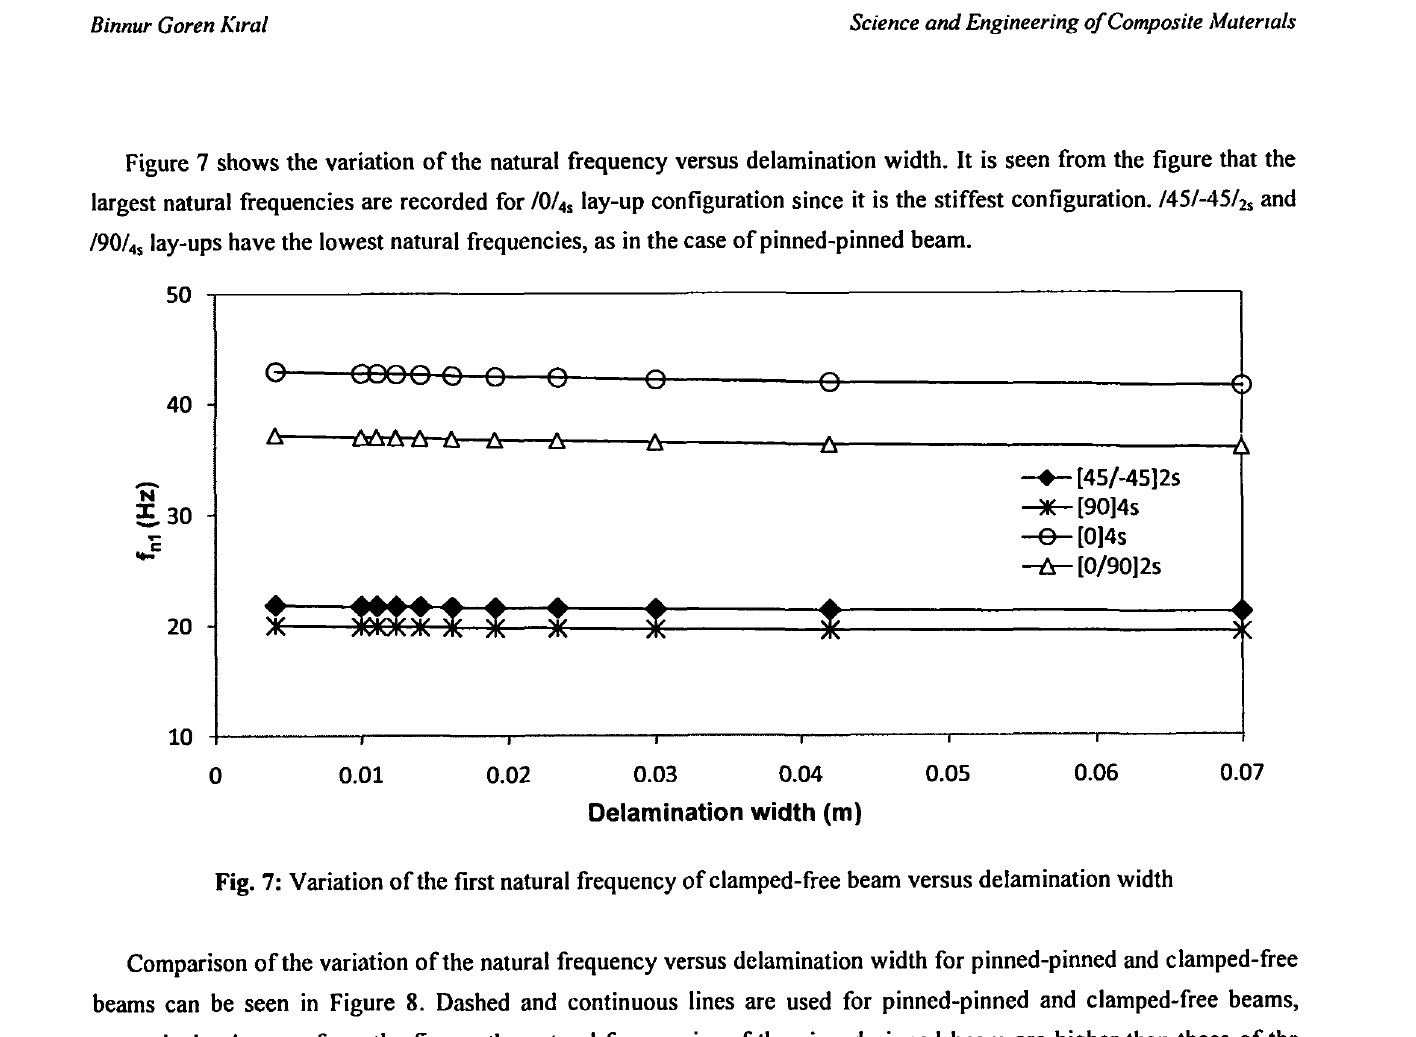
Fig. 7: Variation of the first natural frequency of clamped-free beam versus delamination width Comparison of the variation of the natural frequency versus delamination width for pinned-pinned and clamped-free beams can be seen in Figure 8. Dashed and continuous lines are used for pinned-pinned and clamped-free beams, respectively. As seen from the figure, the natural frequencies of the pinned-pinned beam are higher than those of the clamped-free beam.